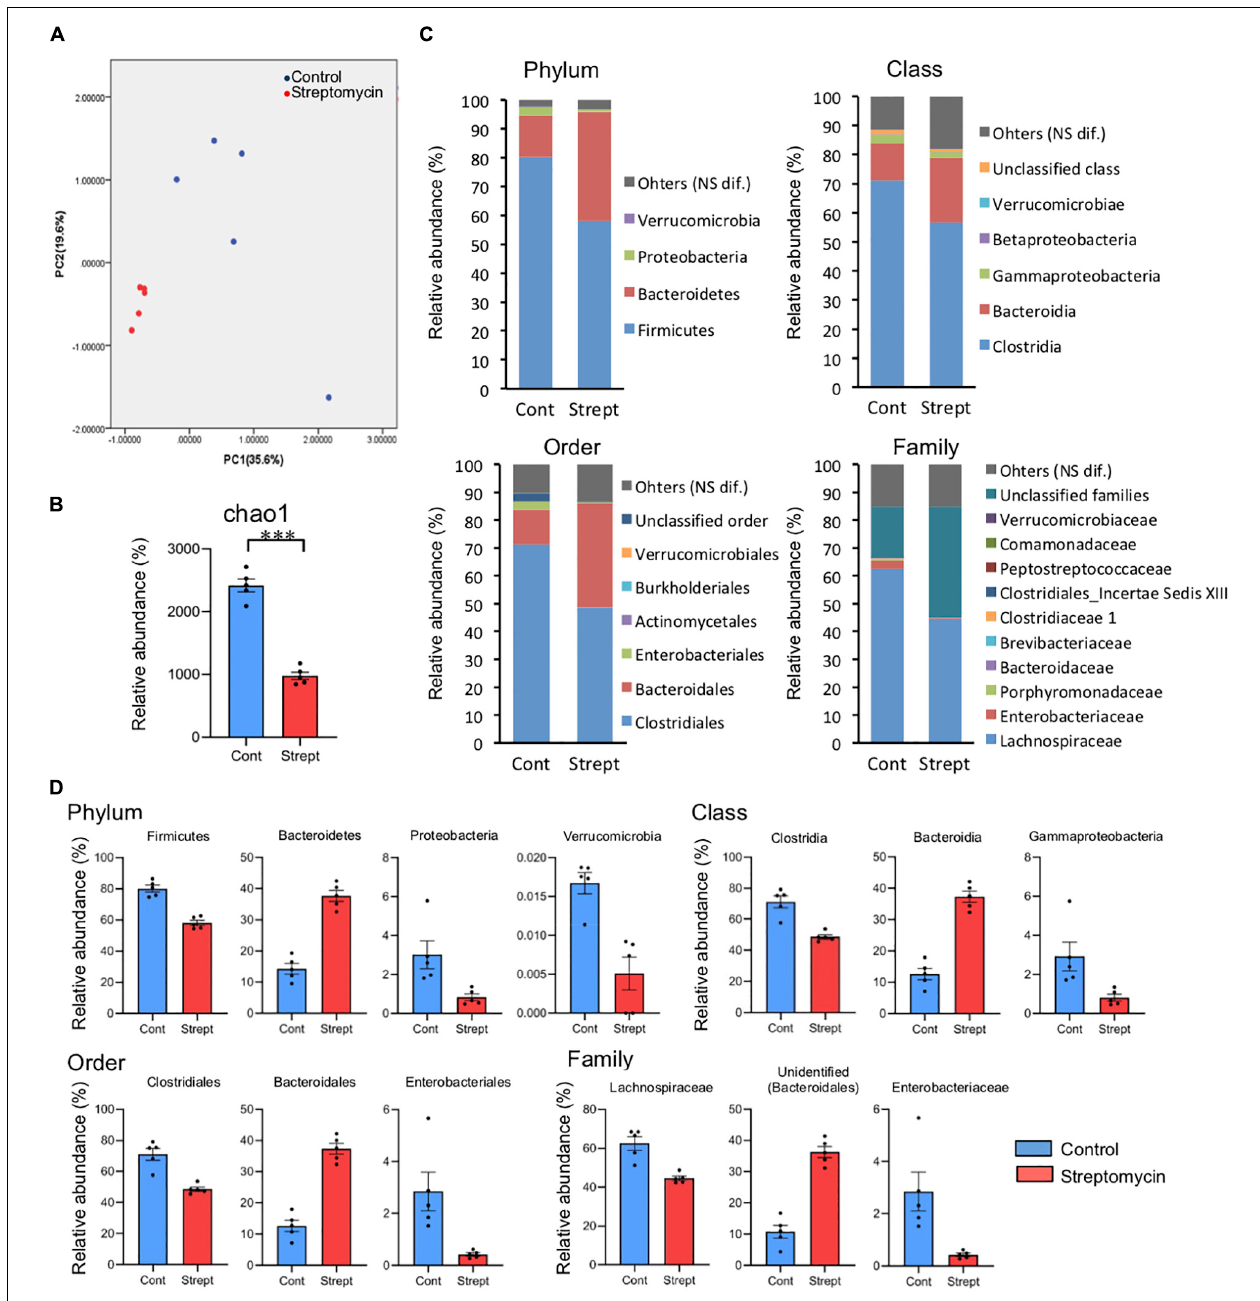
FIGURE 5 | Comparison of relative abundance between control and streptomycin-treated mice. (A) Principle component analysis of the profiling data from fecal microbiota at the genus level. (B) Diversity analysis (Chao 1) of fecal microbiota. (C) The relative abundance of fecal microbiota at phylum, class, order, and family levels, expressed in percentage. Bacterial names showing significant difference between both groups are listed ( q < 0.05, Mann–Whitney U -test corrected using the Benjamini–Hochberg method). (D) The comparison of relative abundance of predominant bacteria, which may be related to cognitive flexibility. The relative abundance of predominant bacteria in control and streptomycin-treated mice are shown in blue and red, respectively. All shown bacterial groups demonstrate significant